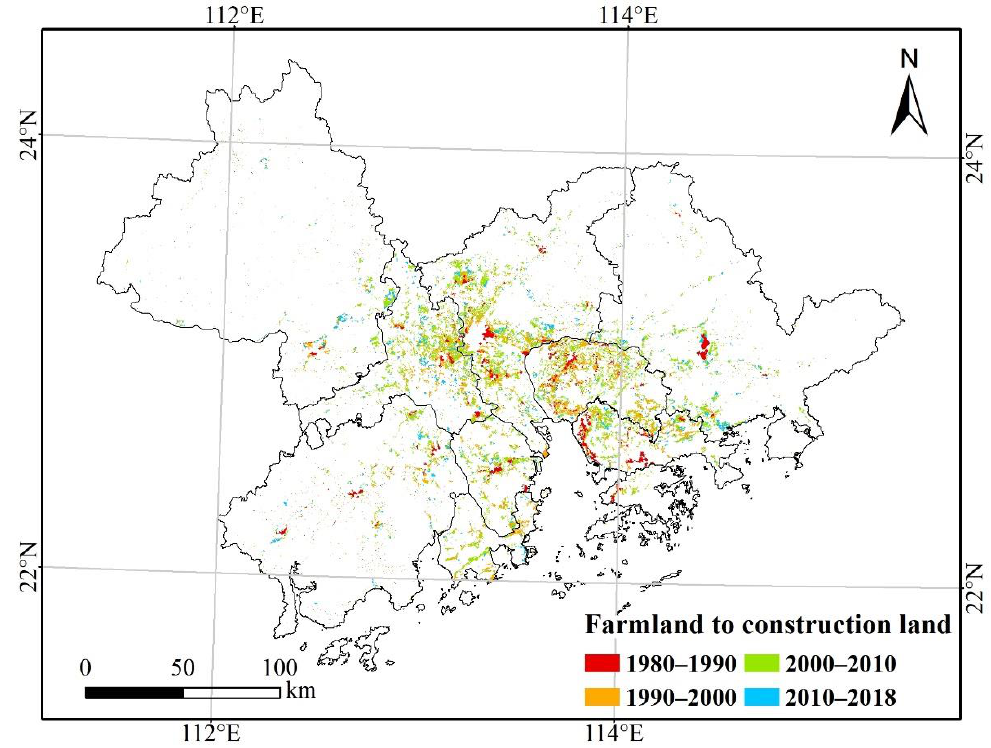
Figure 4. Spatial and temporal distribution of farmland loss due to urbanization in the GBA from 1980 to 2018.